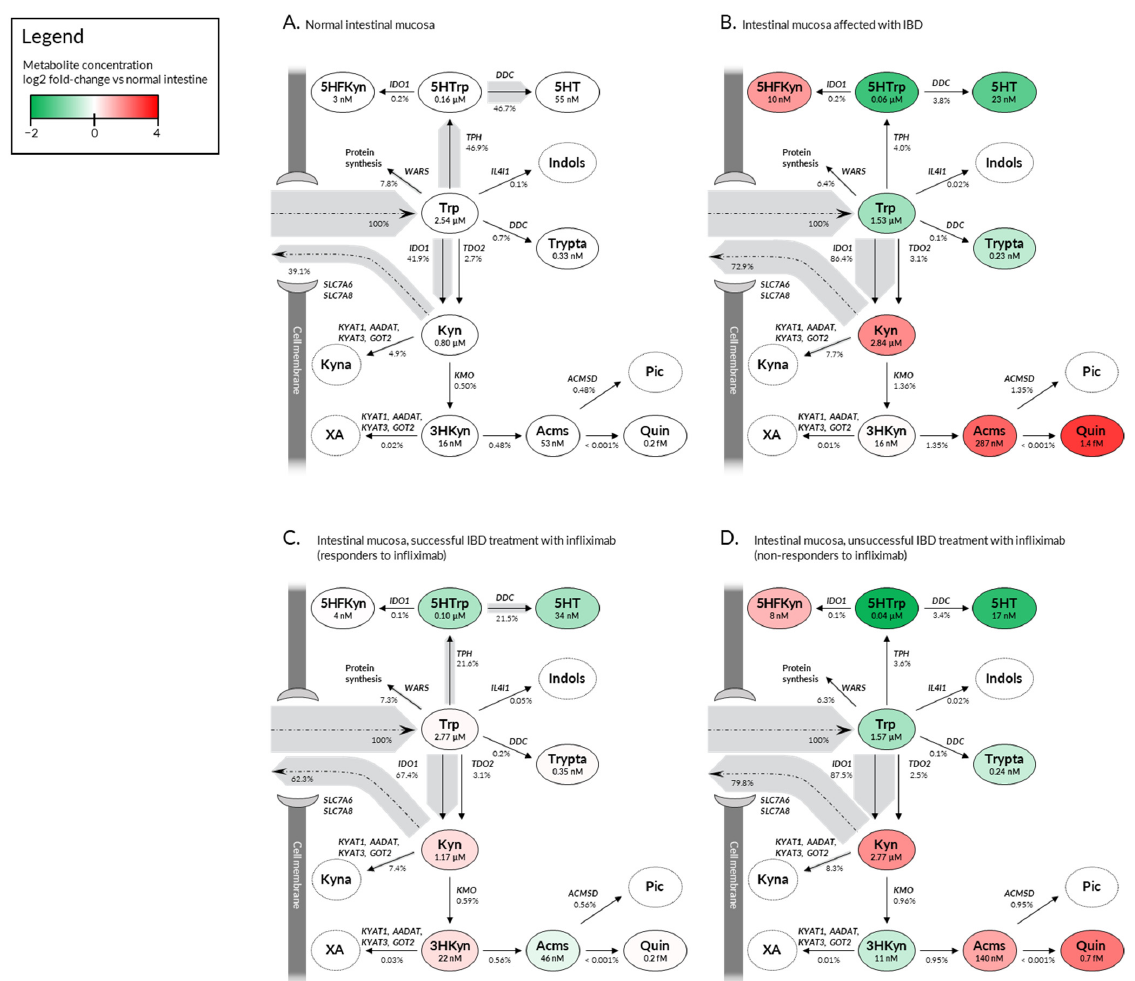
Figure 3. Predicted flux distribution for tryptophan metabolism in the intestine mucosa. ( A ) normal intestinal mucosa (healthy control); ( B ) intestinal mucosa affected with IBD; untreated or placebo treated patients; ( C ) intestinal mucosa successfully treated with infliximab; patients responding to the biologic therapy; ( D ) intestinal mucosa unsuccessfully treated with infliximab; patients non-responsive to the biologic therapy. For simplicity, only the main metabolic compounds and reactions are shown. The width of the shaded area around the arrow represents the predicted flux relative to tryptophan inflow. Relative fluxes and metabolite concentrations are indicated. Trp, tryptophan; Kyn, kynurenine; Kyna, kynurenic acid; 3HKyn, 3-hydroxy-kynurenine; XA, xanthurenic acid; Acms, 2-amino-3-carboxymuconate semialdehyde; Pic, picolinic acid; Quin, quinolinic acid; 5HTrp, 5-hydroxytryptophan; Trypta, tryptamine; 5HFKyn, 5-hydroxy-N-formylkynurenine; ACMSD , 2-amino-3-carboxymuconate semialdehyde-decarboxylase; IL4I1 , interleukin 4 induced 1; WARS , tryptophanyl- aminoacyl-tRNA synthetase; IDO1 ; indoleamine 2,3-dioxygenase 1; TOD2 , tryptophan 2,3-dioxygenase; DDC , aromatic L -amino acid decarboxylase; TPH , tryptophan hydroxylase; KYAT1 , kynurenine aminotransferase 1; AADAT , aminoadipate aminotransferase; KYAT3 , kynurenine aminotransferase 3; GOT2 , glutamic-oxaloacetic transaminase 2; KMO , kynurenine 3-monooxygenase; SLC7A5 , large neutral amino acids transporter small subunit 1; SLC7A8 , large neutral amino acids transporter small subunit